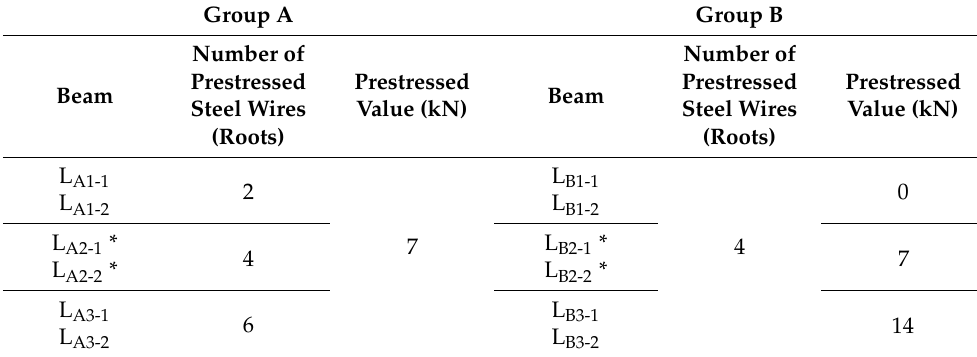
Table 1. Grouping information of test components. Group A Group B Number of Prestressed Prestressed Beam Steel Wires (Roots)